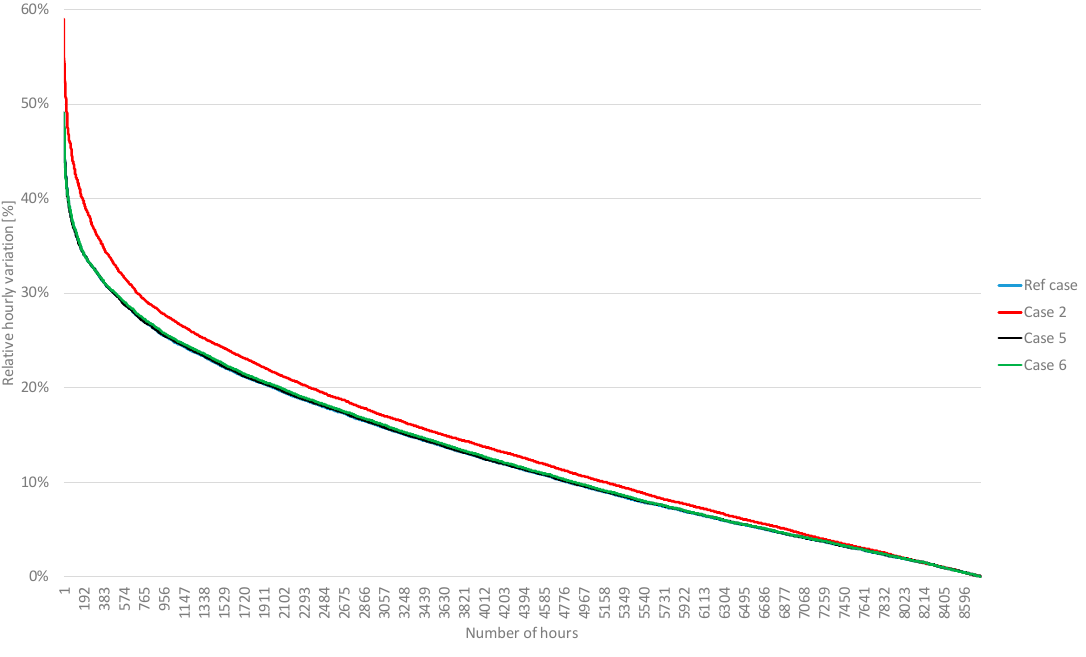
Figure A2. Heat load curve in the reference case without storage in the system.